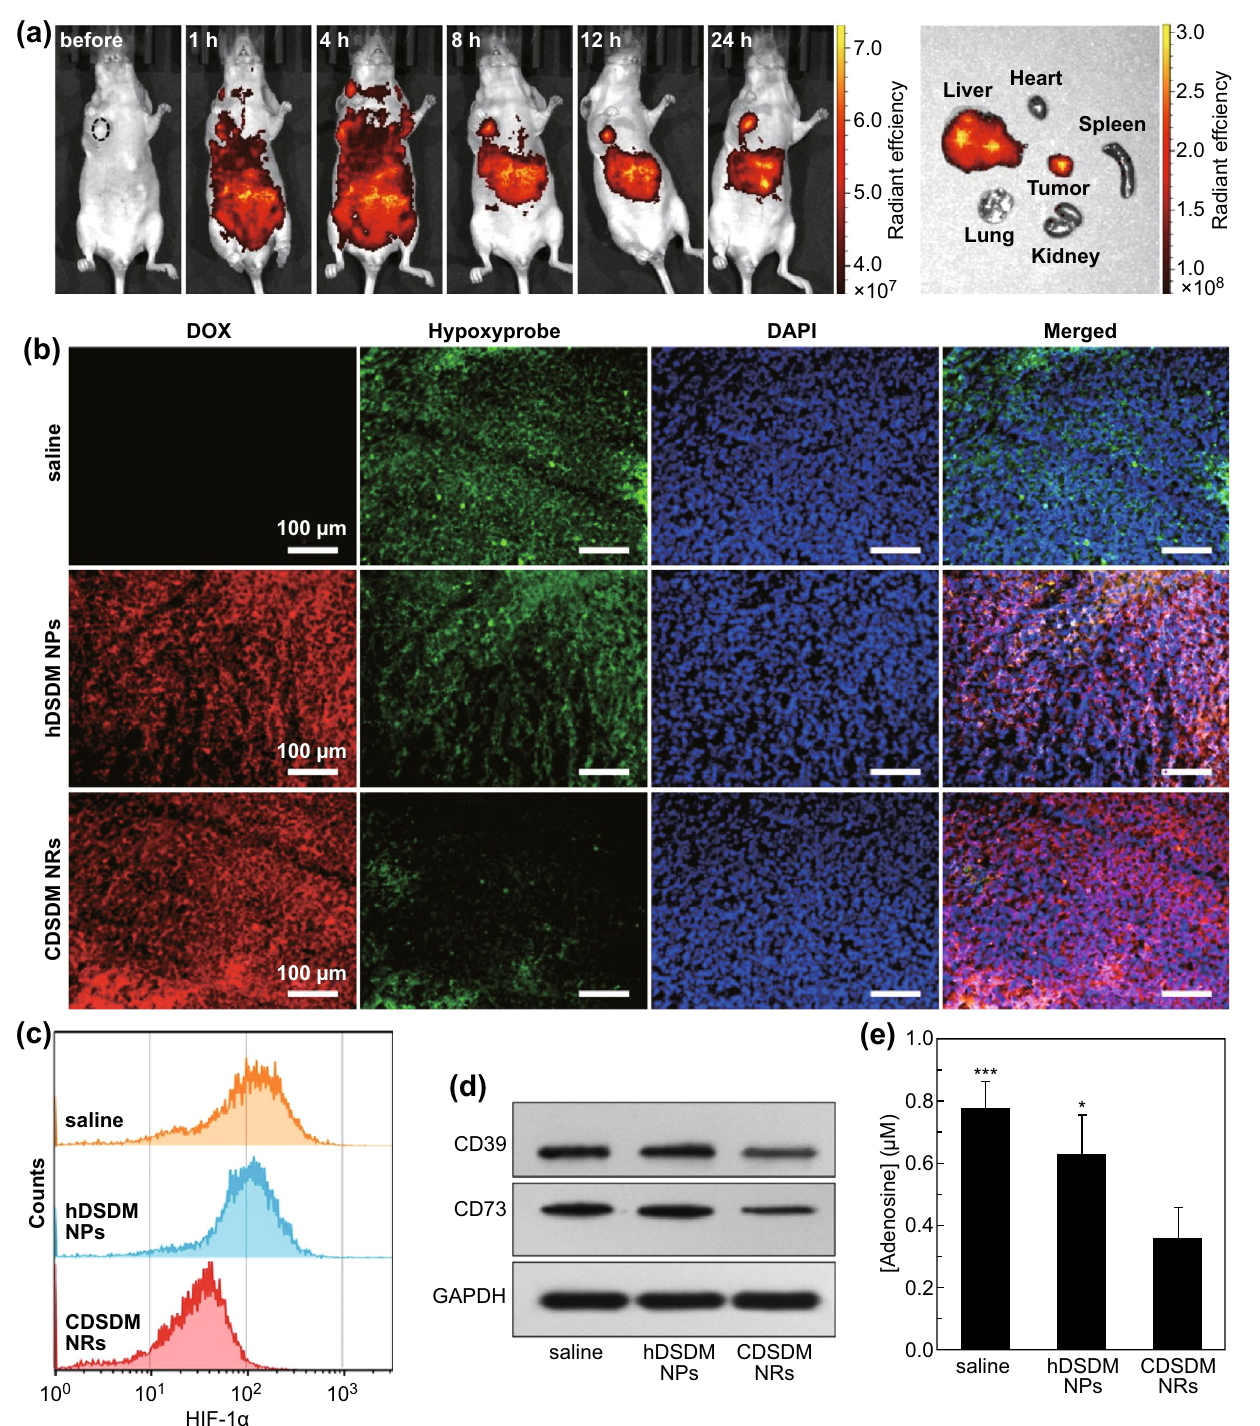
Fig. 3 a In vivo fluorescence monitoring of the distribution of CDSDM NRs in B16F10 tumor‑bearing mice at scheduled time points post‑ intravenous injection, and ex vivo fluorescence of major organs and tumor 8‑h post‑injection. b Fluorescence imaging of tumor tissue sections after receiving different treatments, in which signals include DOX fluorescence, Hypoxyprobe (hypoxia indicator) and DAPI. c Flow cytometric analysis of the intratumoral HIF‑1α level after different treatments. d Western blot results of the expressions of CD39 and CD73 on intratumoral T lymphocytes after 2 days of the indicated treatments. e Concentrations of extracellular adenosine in tumor tissue after 2 days of the indicated treatments. * P < 0.05; *** P < 0.001 versus the last